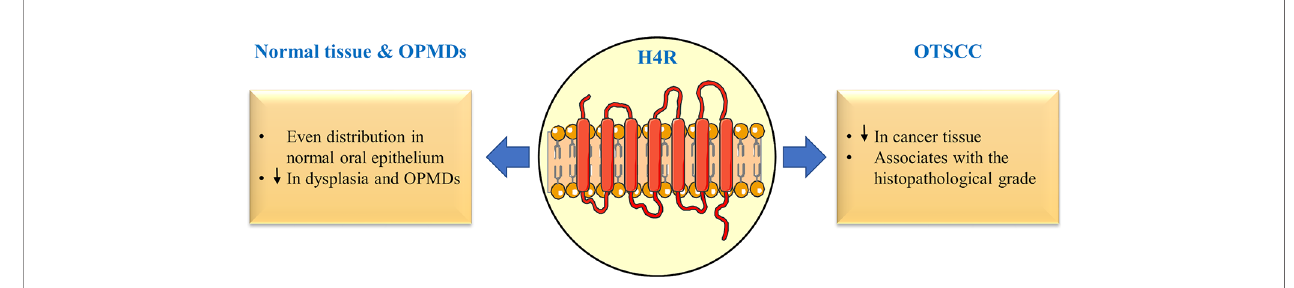
FIGURE 1 | Differential expression of histamine H4 receptor (H4R) in oral potentially malignant disorders (OPMDs) and oral tongue squamous cell